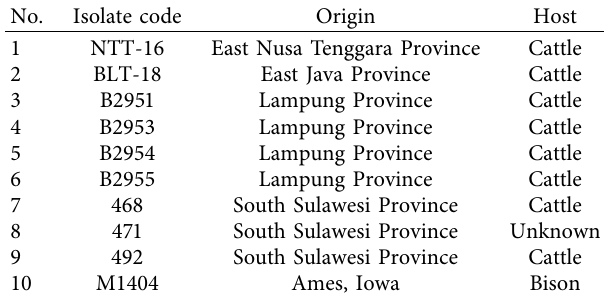
Table 1: P. multocida isolates used in this